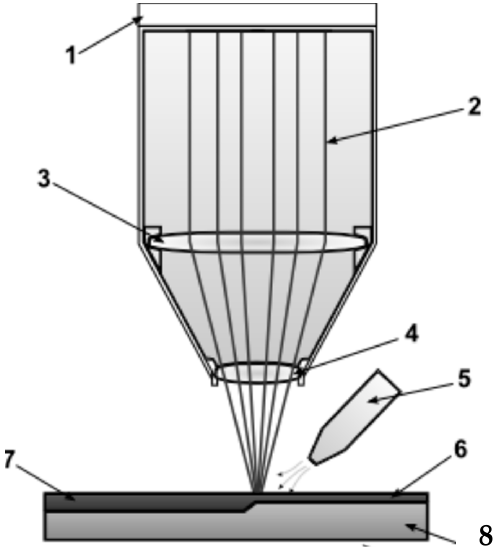
Figure 1. Schematic diagram of the stand for laser feeding of metal powder to the top layer of the insulator guide: 1—laser head, 2—laser beam, 3—focussing lens, 4—protective glass, 5—protective gas nozzle, 6—applied layer alloying material, 7—alloyed layer, 8—native material.